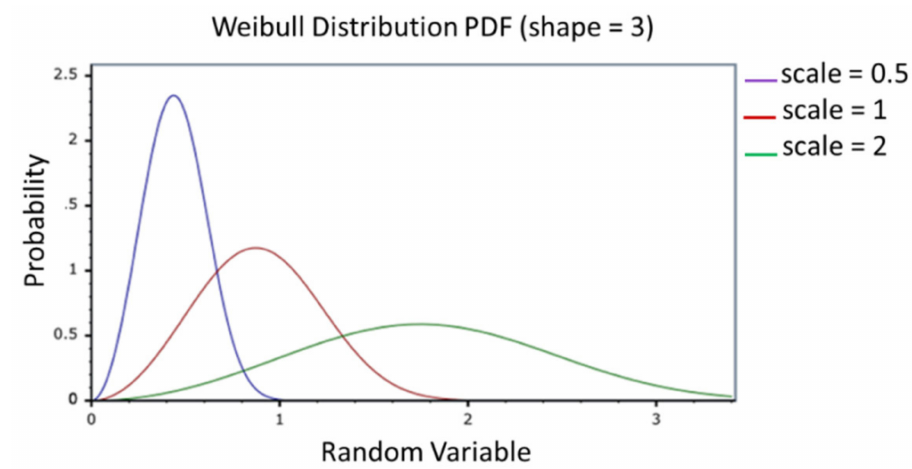
Figure 2. Weibull distribution for different scale